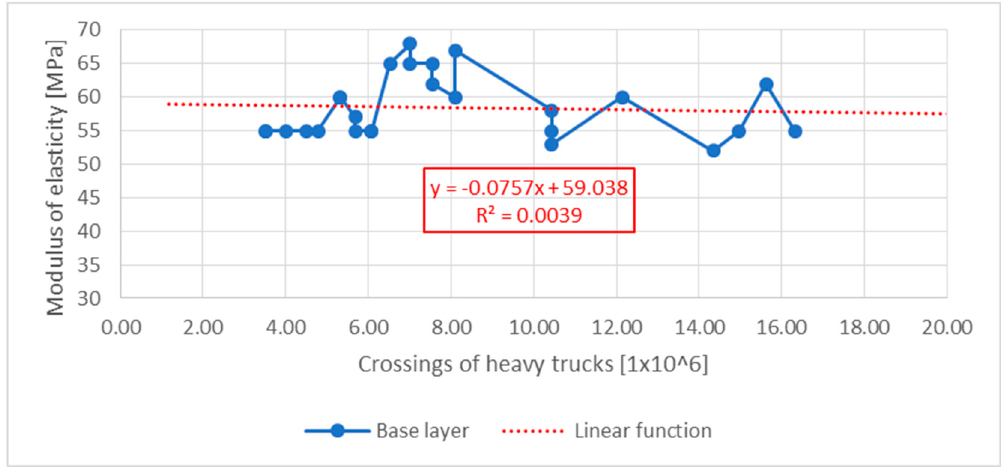
Figure 17. The subsoil Modulus of elasticity course.